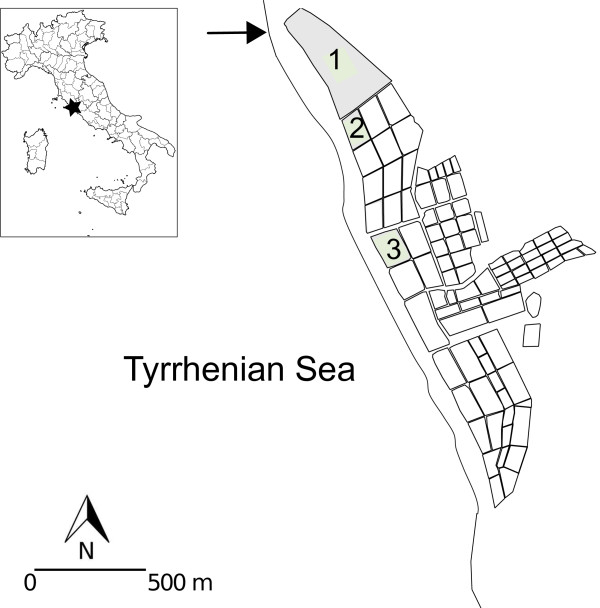
The study area with the sampling sites (in grey). The arrow indicates the channel for marine water refill.